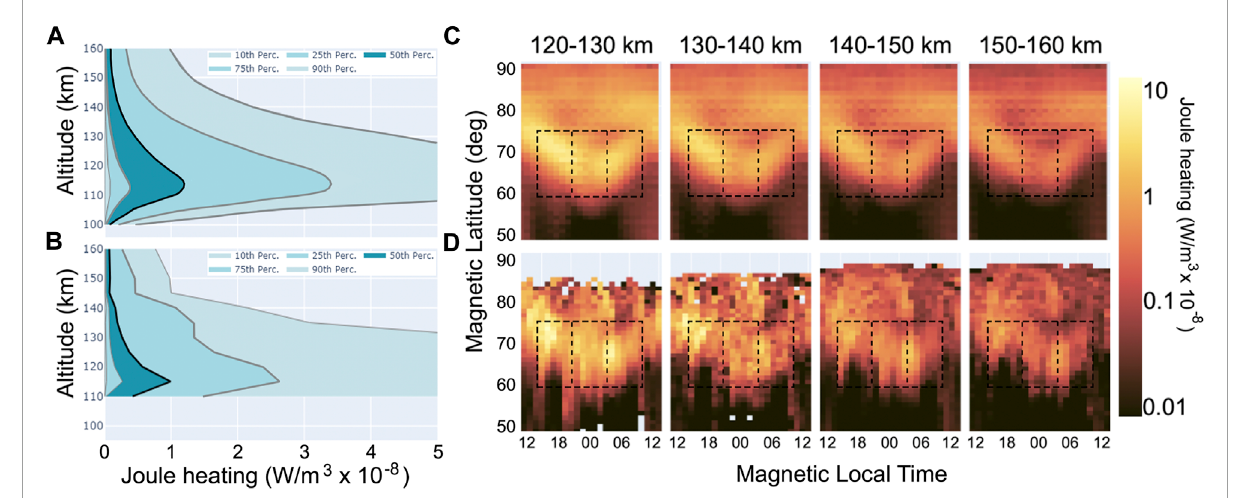
FIGURE 8 (A,B) : Statistical distribution of Joule heating in altitude, as calculated by all gridded data of TIEGCM within magnetic latitudes from 60 to 75° and local time between 21:00 and 03:00 (A) and as sampled along orbit within the same region (B) . (C,D) : Statistical distribution of Joule heating in magnetic latitude and local time, for four altitude bins, as marked, based on all TIEGCM gridded data (C) and along-track sampling (D) .